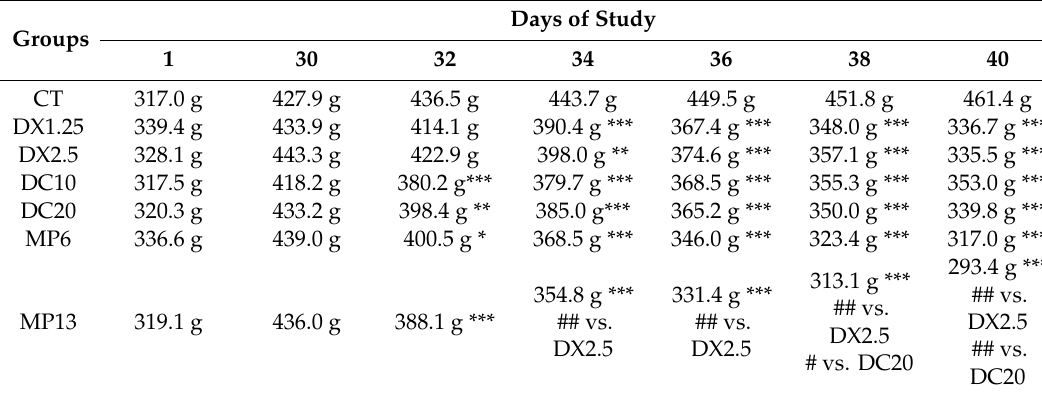
Table 1. Body mass average during the study.